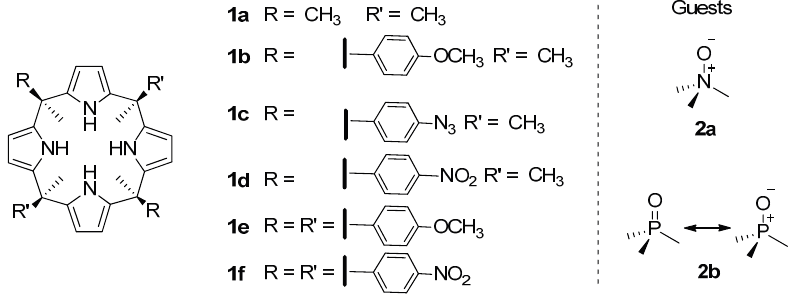
Figure 1. Molecular structures of the calix[4]pyrrole receptors ( 1a – 1f ) and guests ( 2a and 2b ) used in this